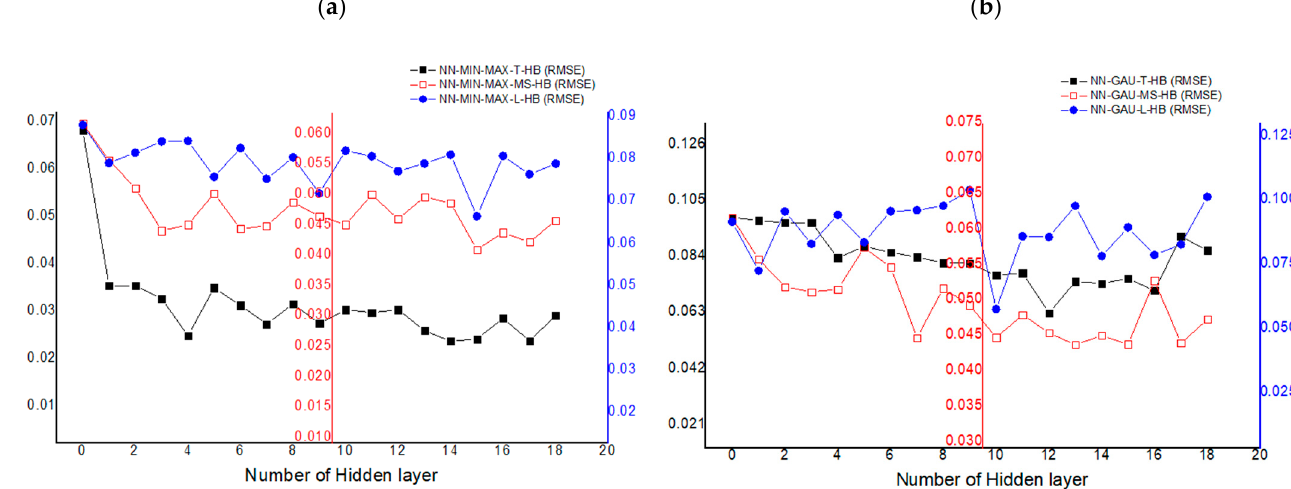
Figure 7. The coefficient of determination and root mean square error (RMSE) of neural network Min–Max normalized versus neural network Gaussian normalized model for hidden layer number: ( a ) coefficient of determination of neural network Min–Max normalized (NN-MM) for hidden layer number; NN-MM total size class (T-HB), small-to-medium-class (MS-HB) and large-class hydraulic breakers (L-HB); ( b ) coefficient of determination of neural network with Gaussian normalized (NN- GAU) for hidden layer number; NN-GAU total size class (T-HB), small-to-medium-class (MS-HB) and large-class hydraulic breakers (L-HB); ( c ) root mean square error of NN mm for hidden layer number; NN mm total size class (T-HB), small-to-medium-class (MS-HB) and large-class hydraulic breakers (L-HB); ( d ) root mean square error of neural network with Gaussian normalized (NN-GAU) for hidden layer number; NN-GAU total size class (T-HB), small-to-medium-class (MS-HB) and large-class hydraulic breakers